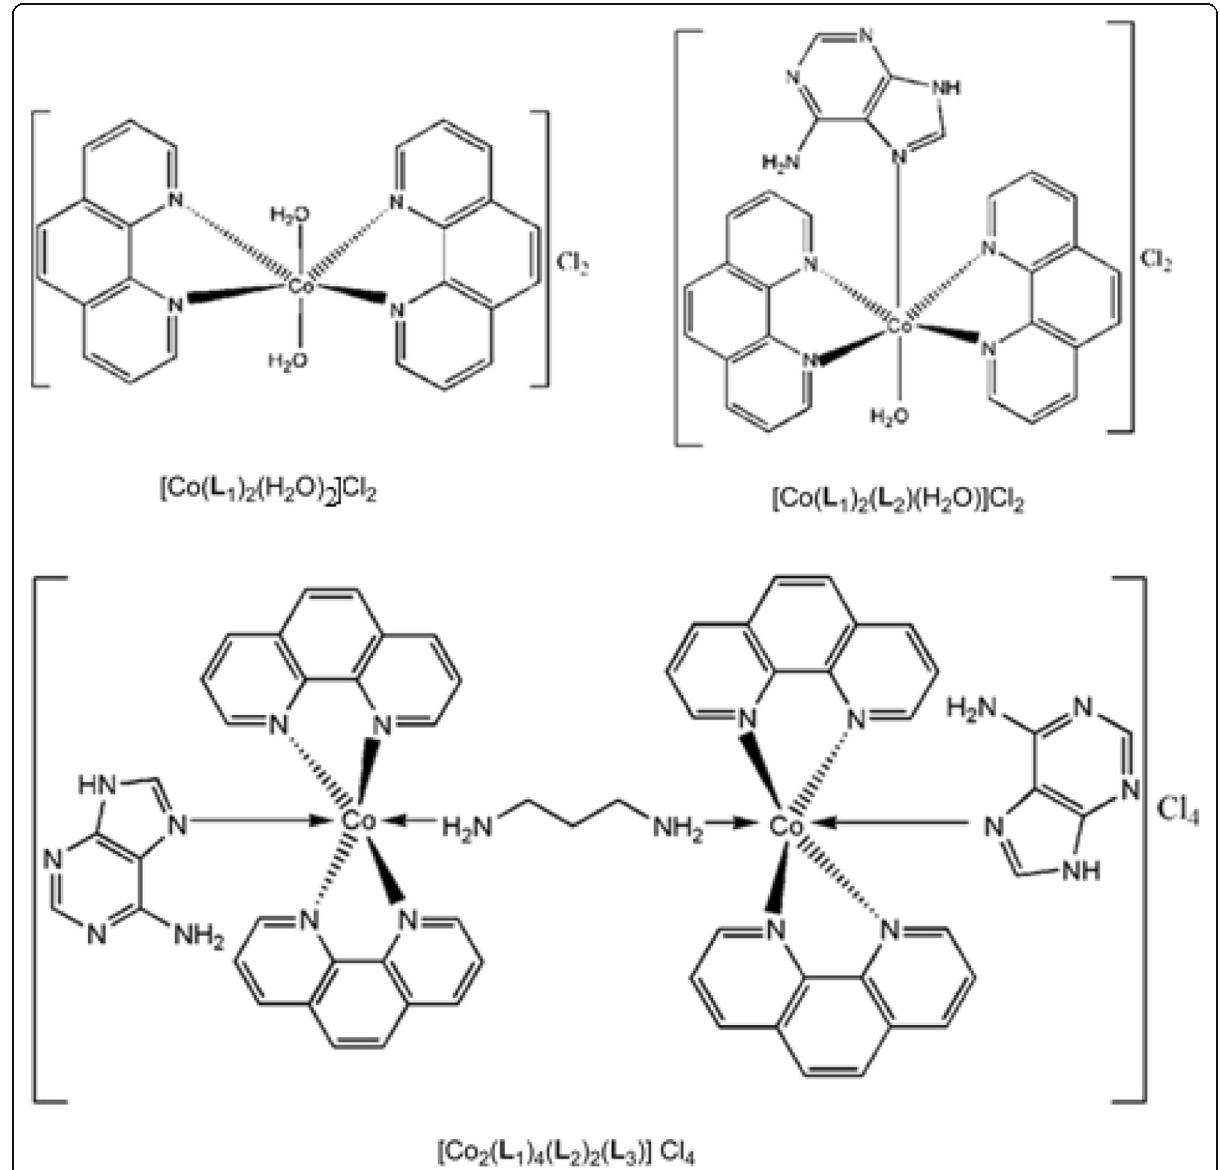
Fig. 5 The proposed structures of the complexes 1 –